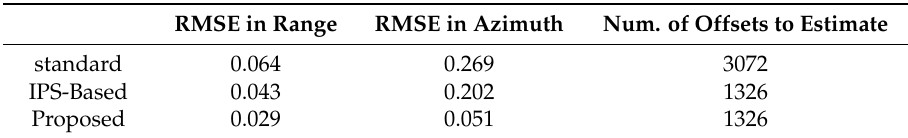
Table 2. The root mean square error (RMSE) values of the offsets and the calculation amounts of co-registration by the three methods.